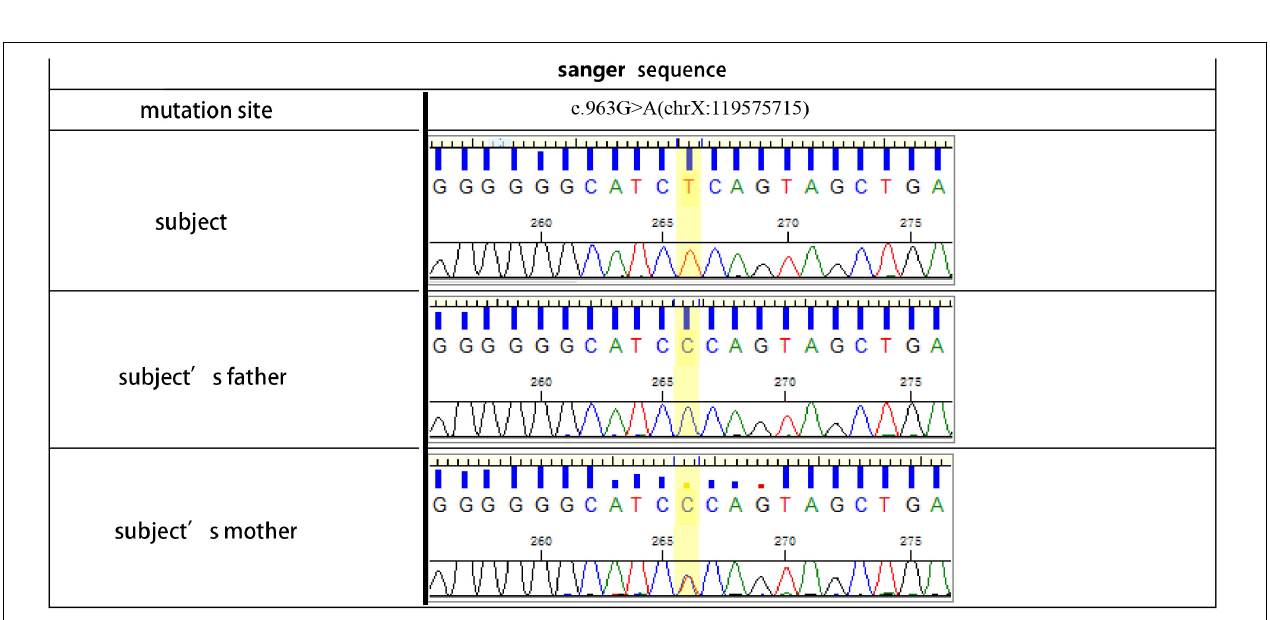
FIGURE 2 | Gene sequence of the III4 (Pt 1, subject), II3 (subject’s father) and II4 (Pt 2, subject’s mother).